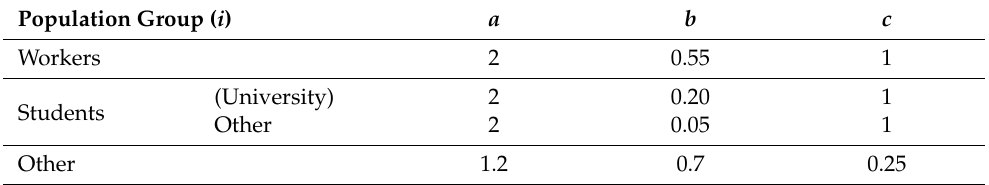
Table 2. Factors used in production/attraction